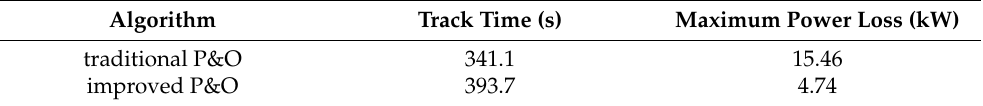
Table 2. Comparison of algorithm effects.